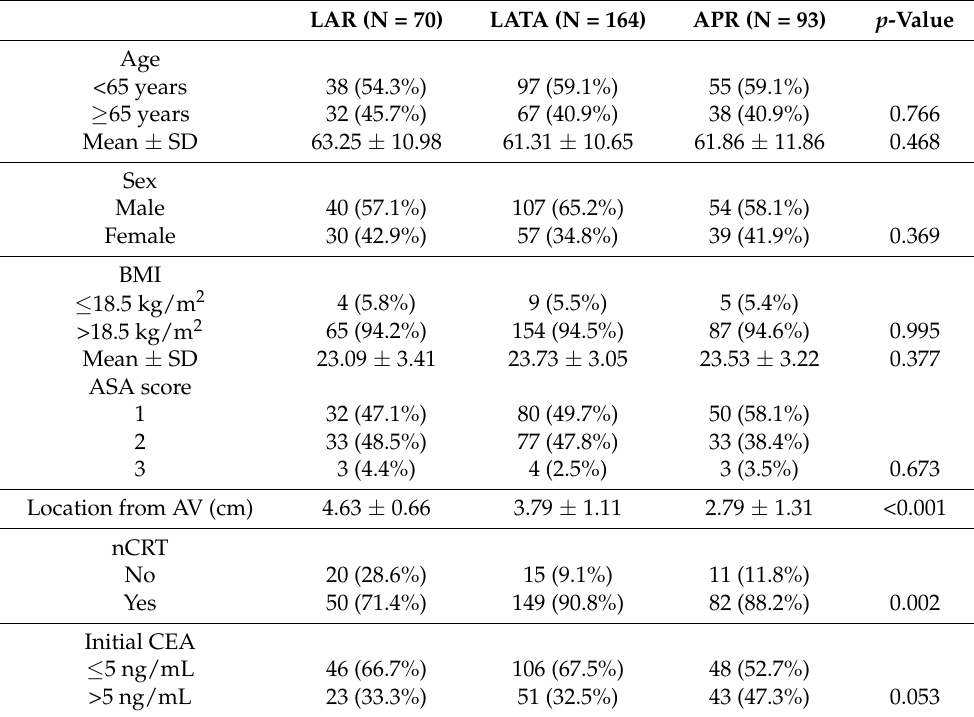
Table 1. Demographics of all enrolled